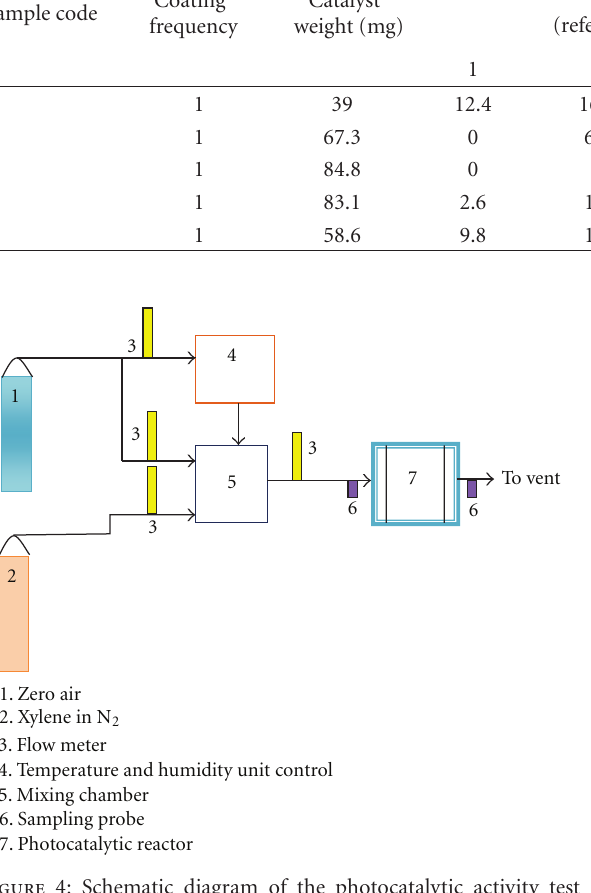
Table 1: Coating frequency, UVA transmittance, and catalyst coating weight results for the lowering technique. Sample code